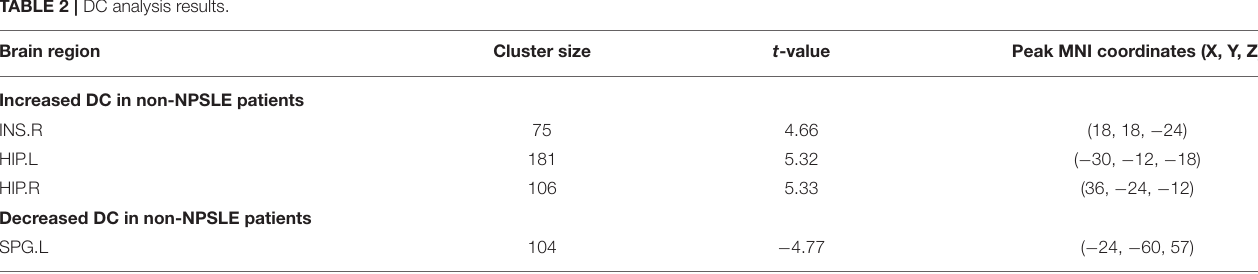
TABLE 2 | DC analysis results. Brain